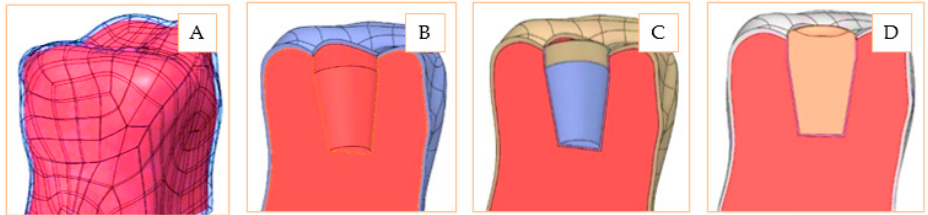
Figure 2. Design stages of inlay model: Basic model including dentine and enamel volumes ( A ); Inner surface generation ( B ); Adhesive cement layer applied to the model ( C ); Restoration ceramic insertion ( D ).